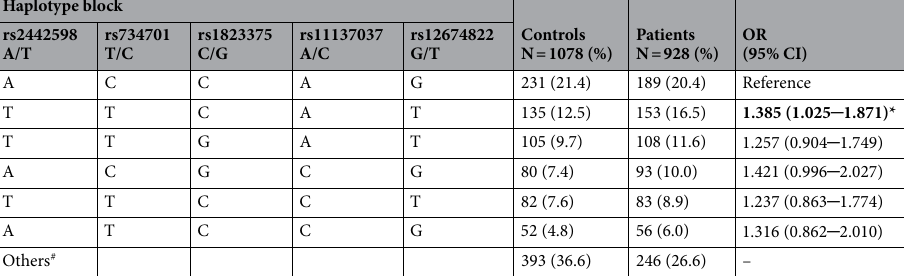
Table 5. Distribution frequencies of ANGPT2 haplotypes in healthy controls and patients with malignant breast neoplasms. The odds ratios (ORs) and their associated 95% confidence intervals (CIs) were estimated by logistic regression models. * p < 0.05 was considered to be statistically significant. # denotes all other 25 haplotypes without significance. Significant values are in